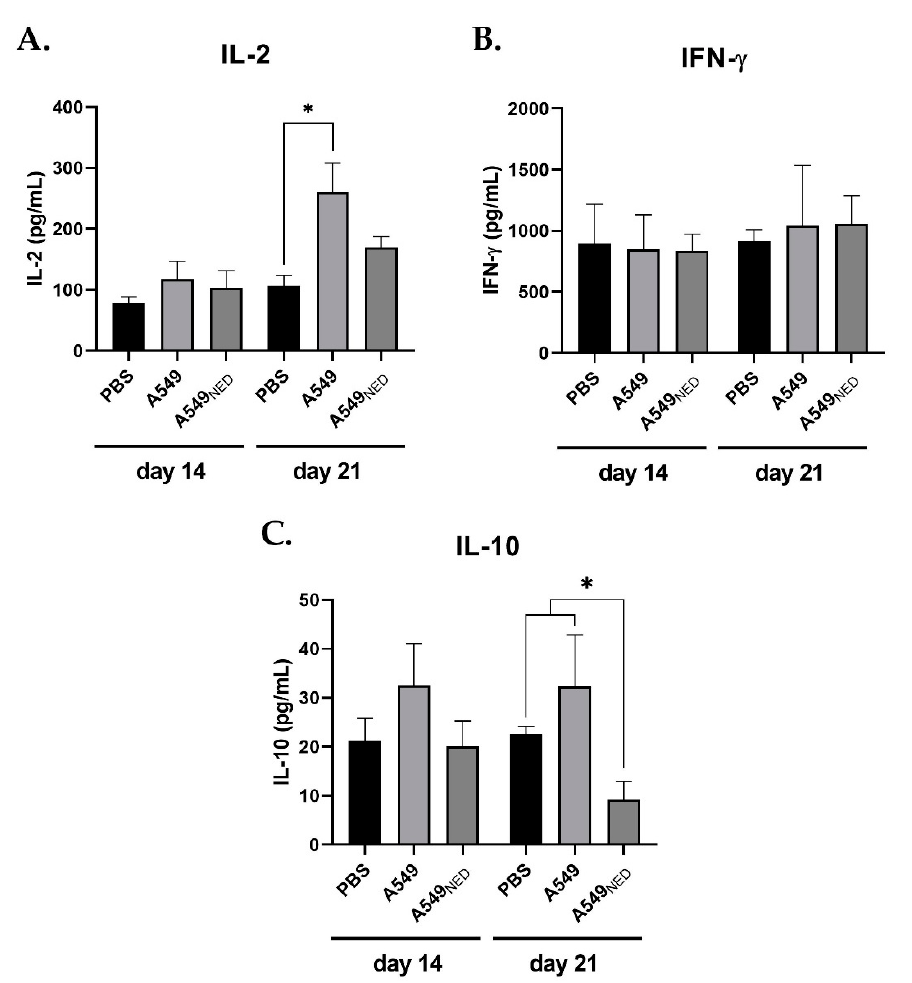
Figure 5. Cytokine levels in immunized mice. The bar graphs show IL-2 ( A ), IFN- γ ( B ), and IL-10 ( C ) levels 14 and 21 days after the first immunization; data are shown in pg/mL (n = 4, * p < 0.05).